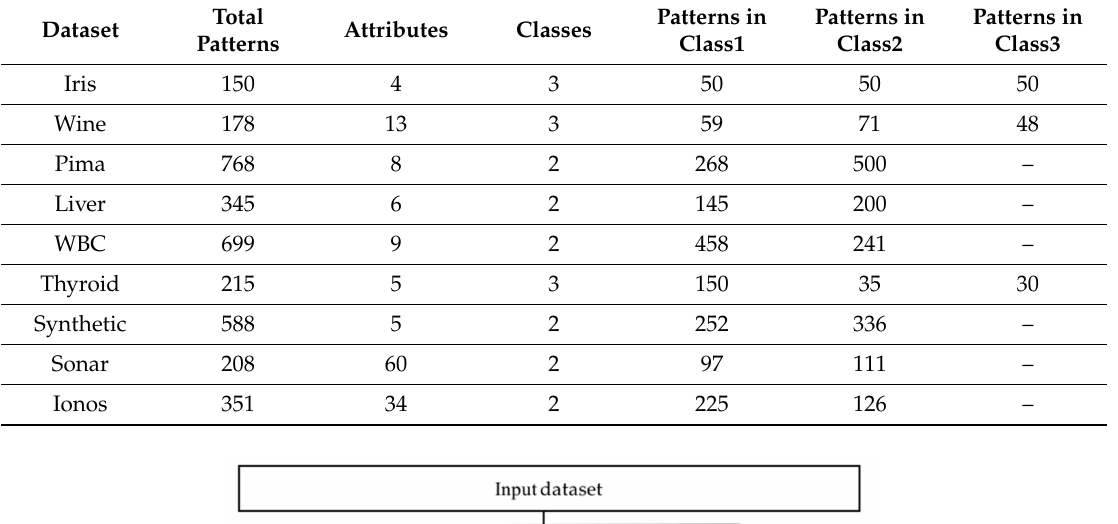
Table 1. Description of datasets used (original).